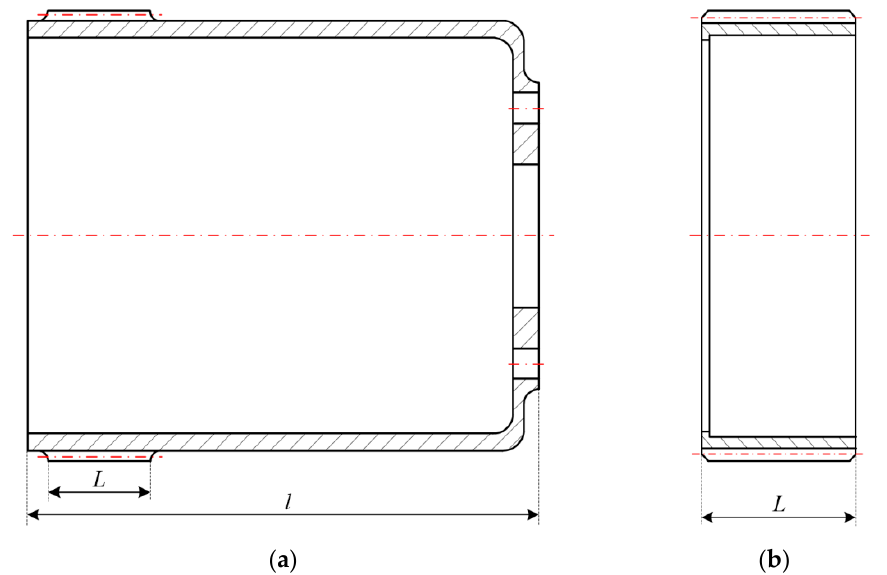
Figure 1. Structure of two kinds of flexible wheels: ( a ) the conventional flexible wheel; ( b ) the disposable flexible wheel.